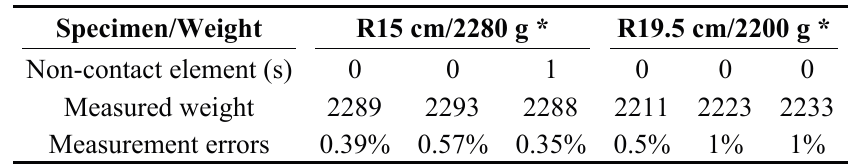
Table 2. Shape setting test